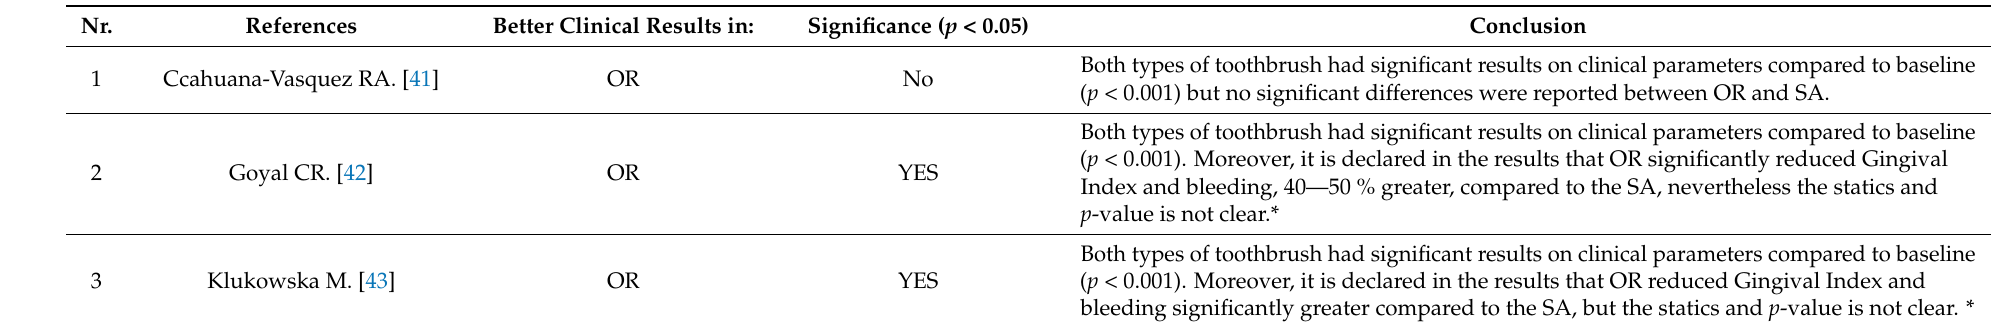
Table 3. Main conclusion of each included study with significance and